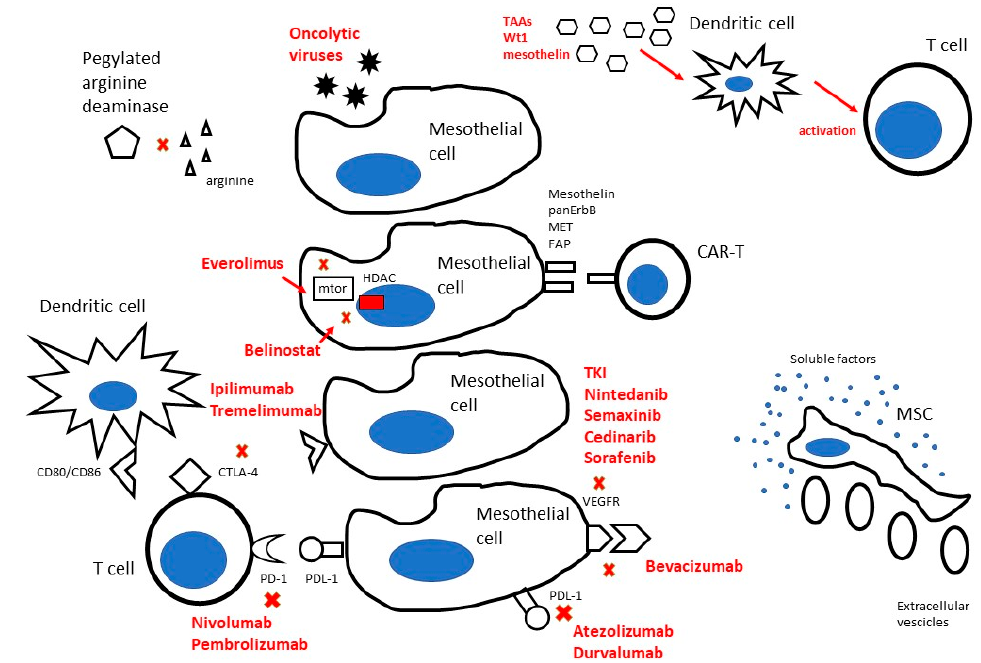
Figure 1. Main local therapeutic strategies for the management of malignant pleural mesothelioma. CAR-T, chimeric antigen receptor T-cell; CTLA-4, Cytotoxic T-Lymphocyte Antigen 4; FAP, Fibroblast Activation Protein; HDAC, histone deacetylase; MSC, mesenchymal stromal cell; mTor, mammalian target of rapamycin; PD-1, Programmed cell death protein 1; PDL ‐ 1, Programmed cell death LIGAND protein 1; VEGFR, vascular endothelial growth factor.